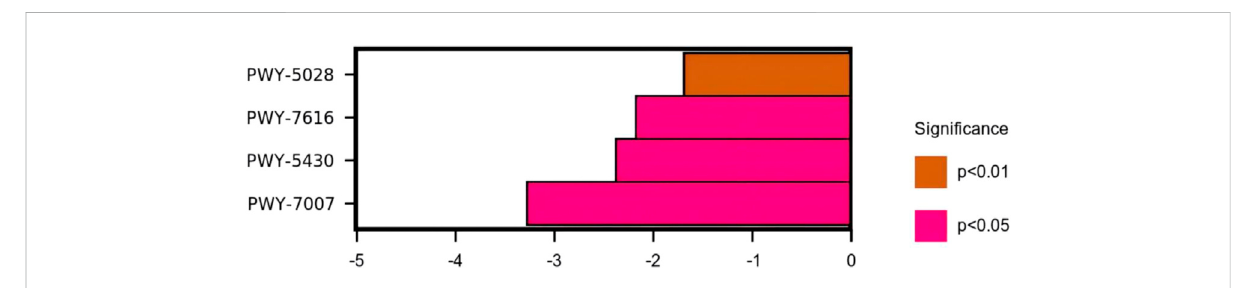
FIGURE 13 Differential analysis of the KEGG metabolic